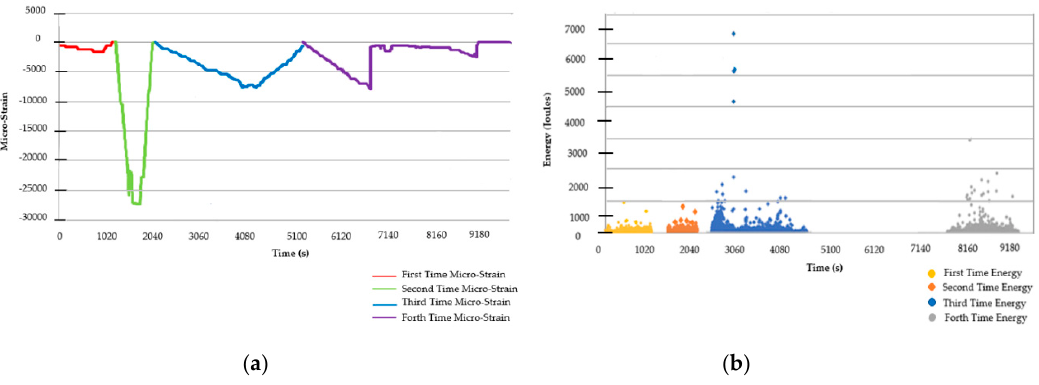
Figure 12. Micro-strain and AE energy over time in tension mode under repeated load test ( a )